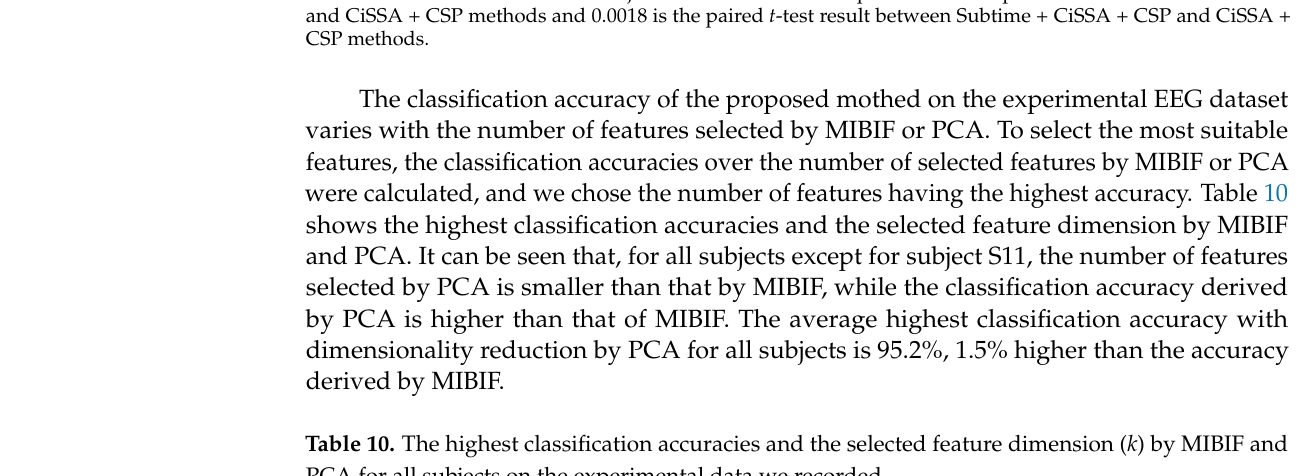
Table 9. Paired t -test ( α = 0.05) result for the classification accuracy on public and experimental datasets. Subtime + CiSSA Subtime + CiSSA Subtime + CiSSA CSP CiSSA + CSP +CSP +CSP + MIBIF +CSP + PCA p -value - 0.0000 0.0018 0.0006 0.0001 Paired t -test is used between two adjacent methods. For example 0.0000 is the paired t -test result between CSP and CiSSA + CSP methods and 0.0018 is the paired t -test result between Subtime + CiSSA + CSP and CiSSA + CSP methods.